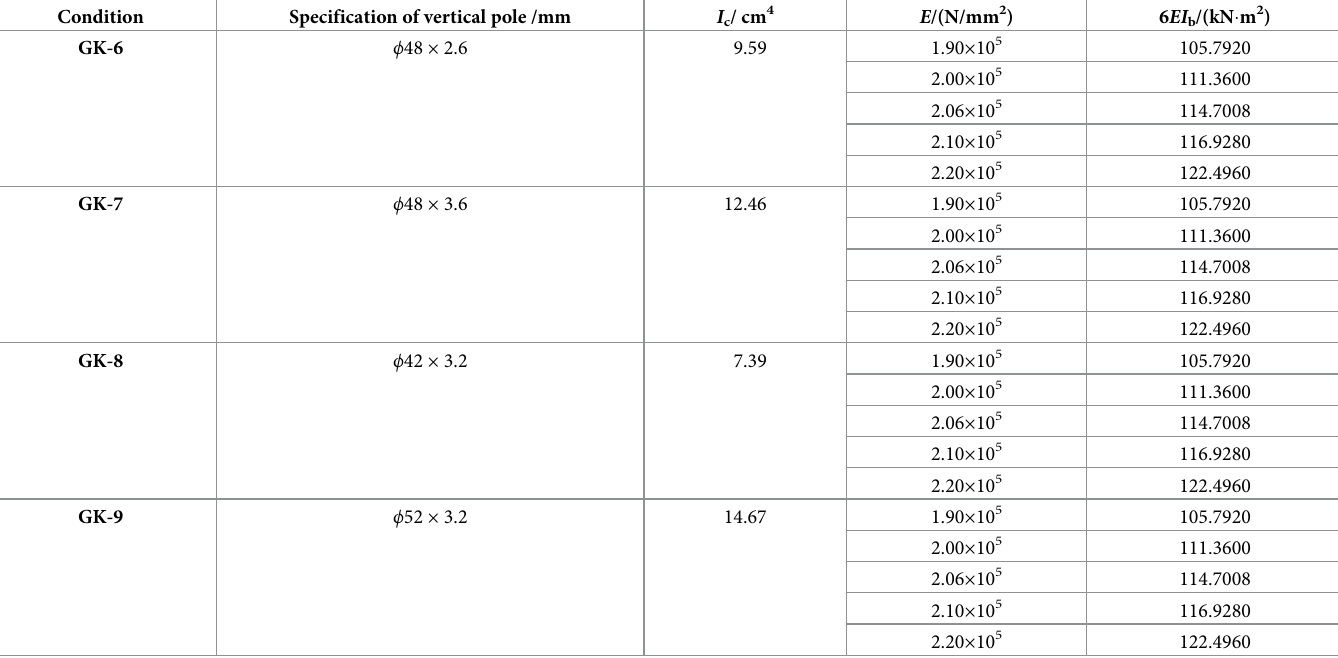
Table 11. Influence parameters of elastic modulus of horizontal bar with specification ϕ 48 ×